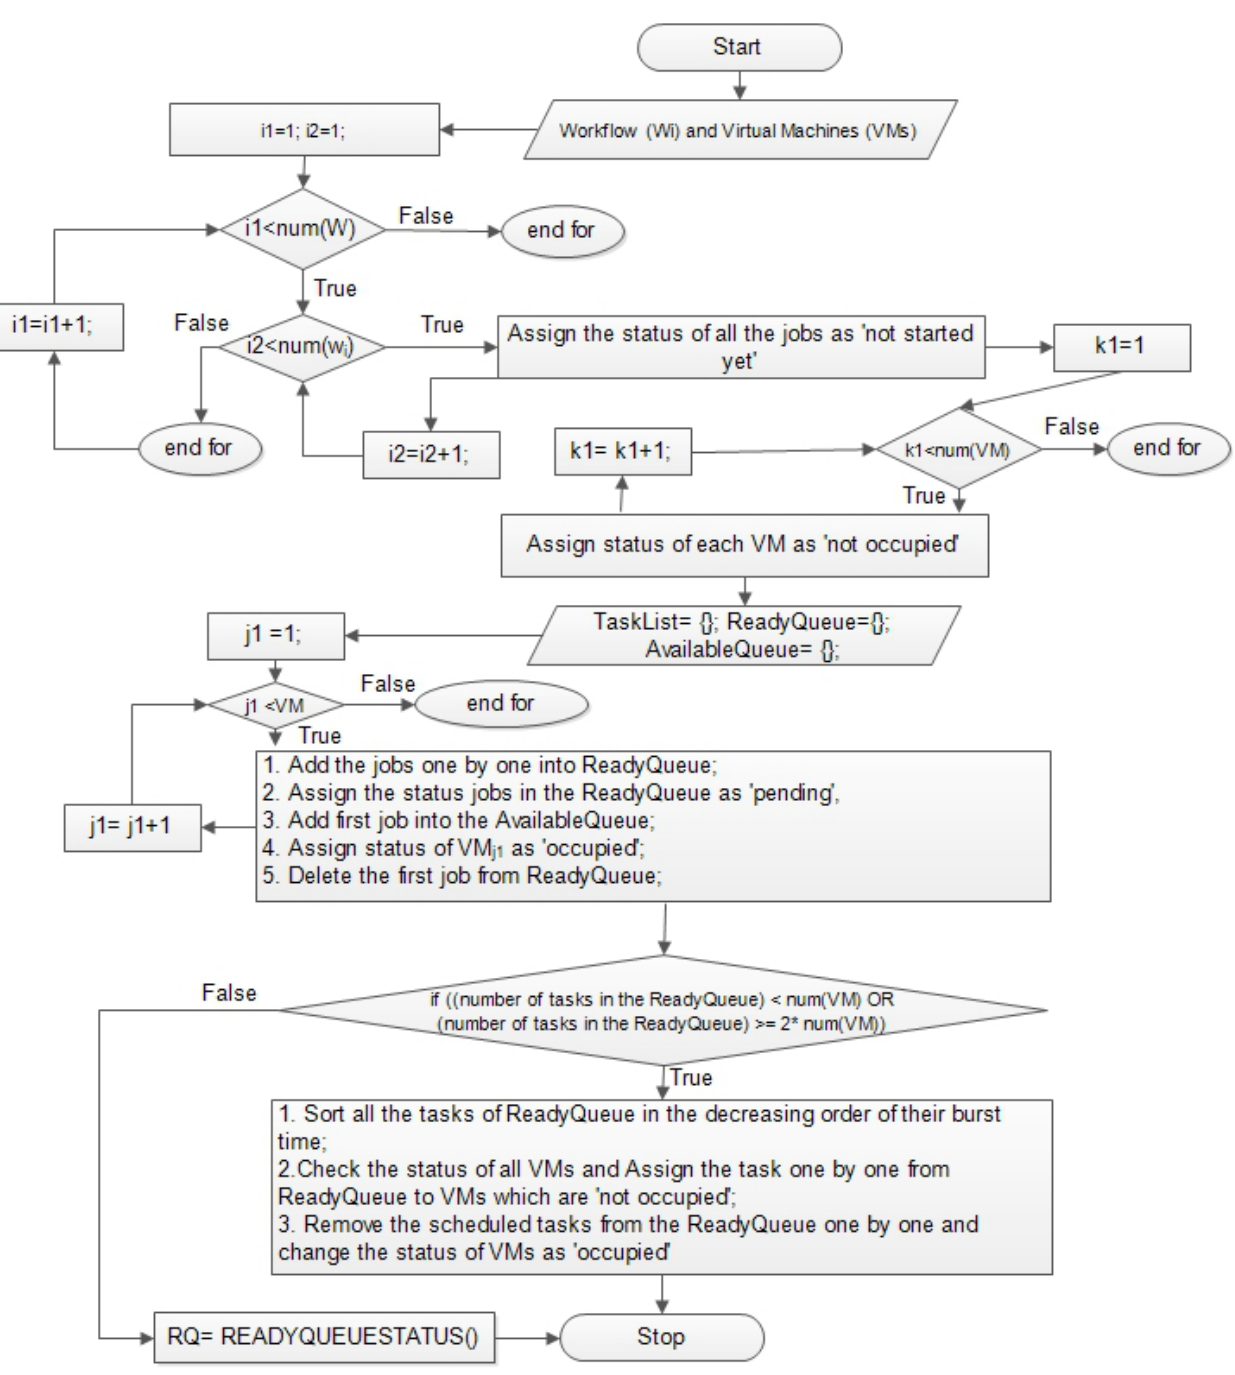
Figure 10. Flowchart of proposed parent to child (P2C)